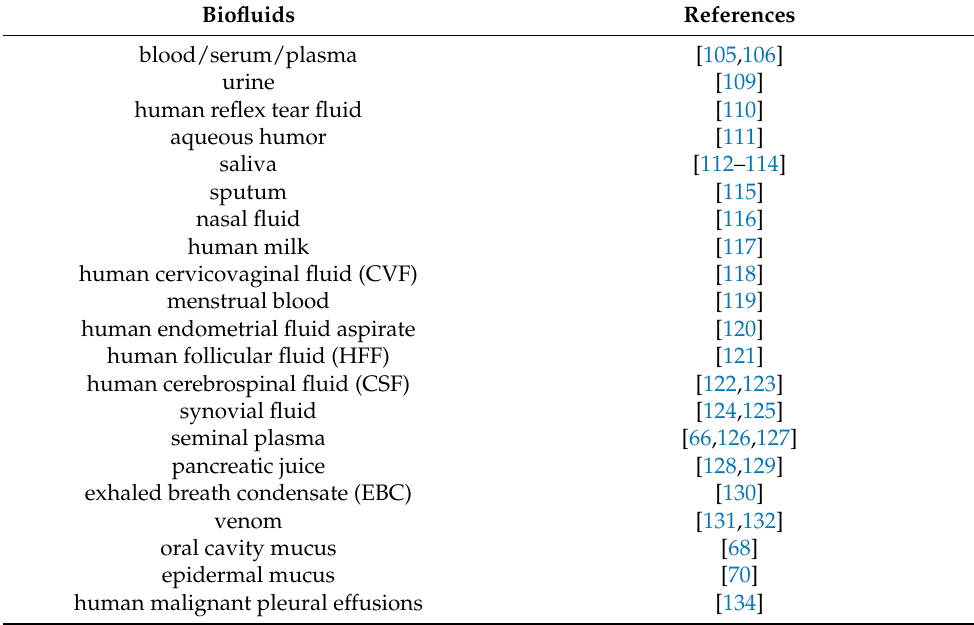
Table 4. Biofluids proteomic analysis using MALDI tandem mass spectrometry.